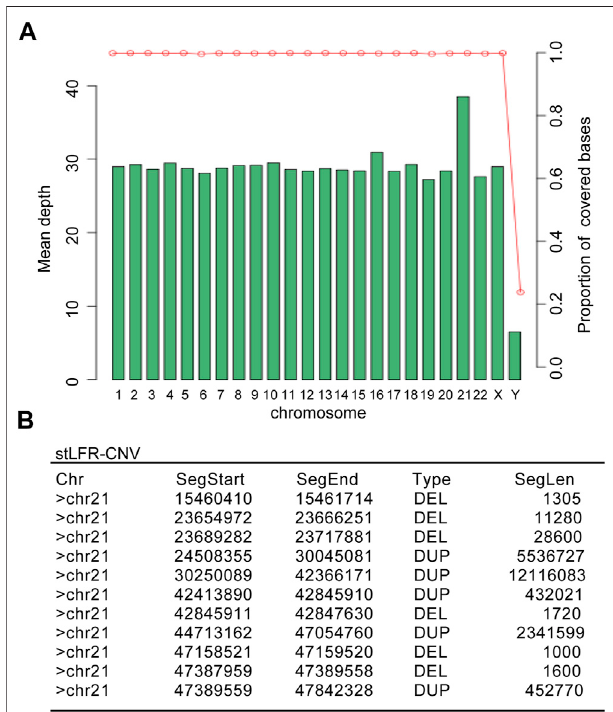
FIGURE 2 | The stLFR whole-genome sequencing result showed multiple duplications and deletions in the proband ’ s Chr21. (A) The mean depth distribution indifferentchromosomesoftheproband. (B) Detailed copy number variations (CNVs) in the proband ’ s Chr21 summarized from the genome sequencing